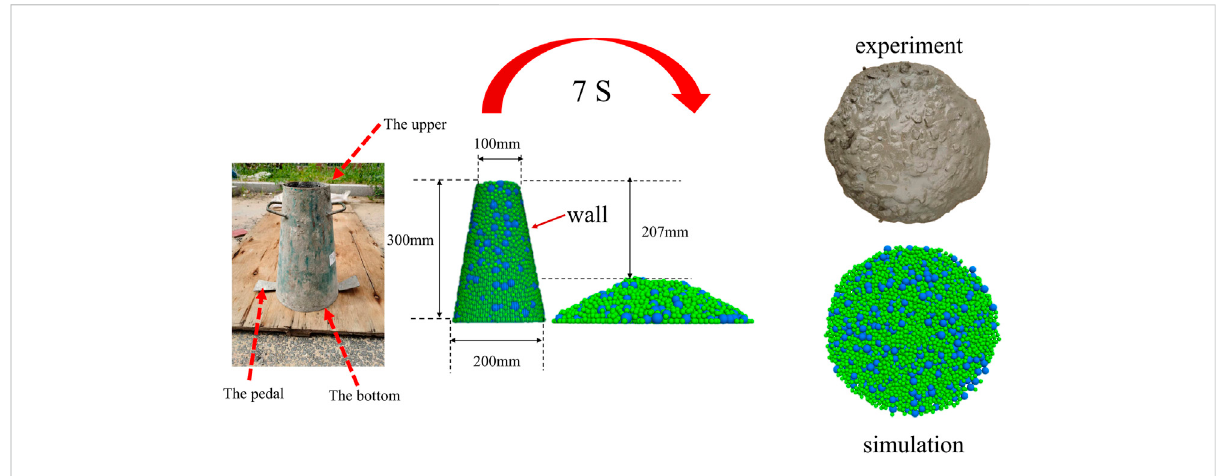
FIGURE 4 Slump experiment and its numerical